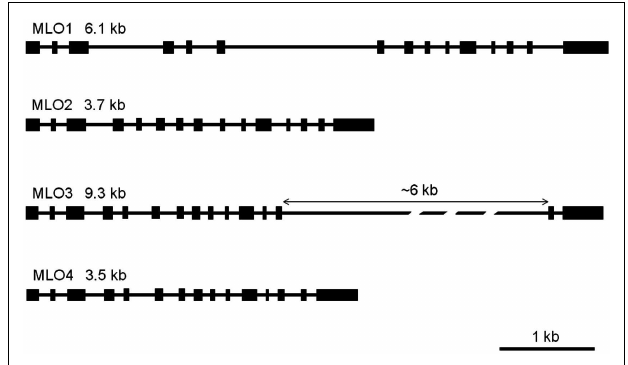
FIGURE 3 | Gene structures of the four rose MLO genes. The genes are built from 15 exons, depicted as boxes, that are interrupted by introns of varying size (black bars).The proportions reflect the actual sizes of introns and exons except for the 6kb intron in MLO3. Gene sizes are given from ATG to STOP in